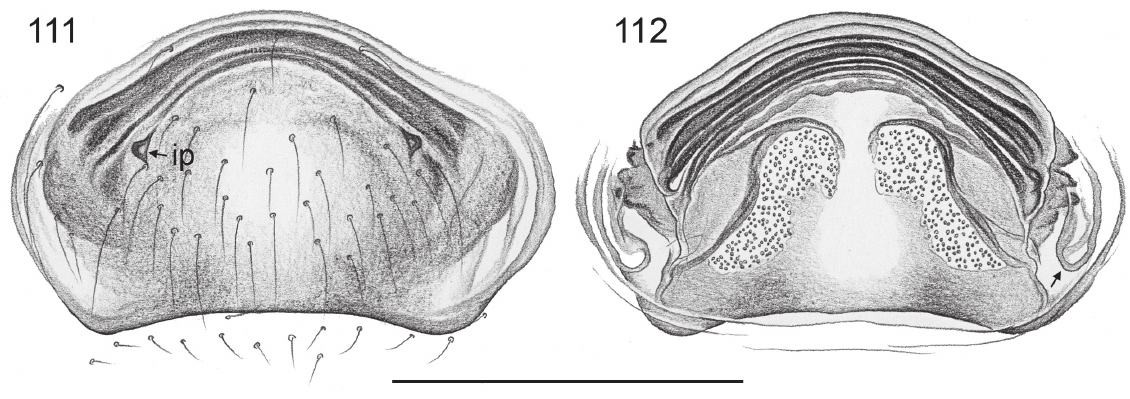
Figs 111–112. Aetana kinabalu Huber, 2005. Cleared female genitalia, ventral and dorsal views (arrow in Fig. 112 points at membranous pocket). ip = internal sclerotized pocket. Scale line: 0.5